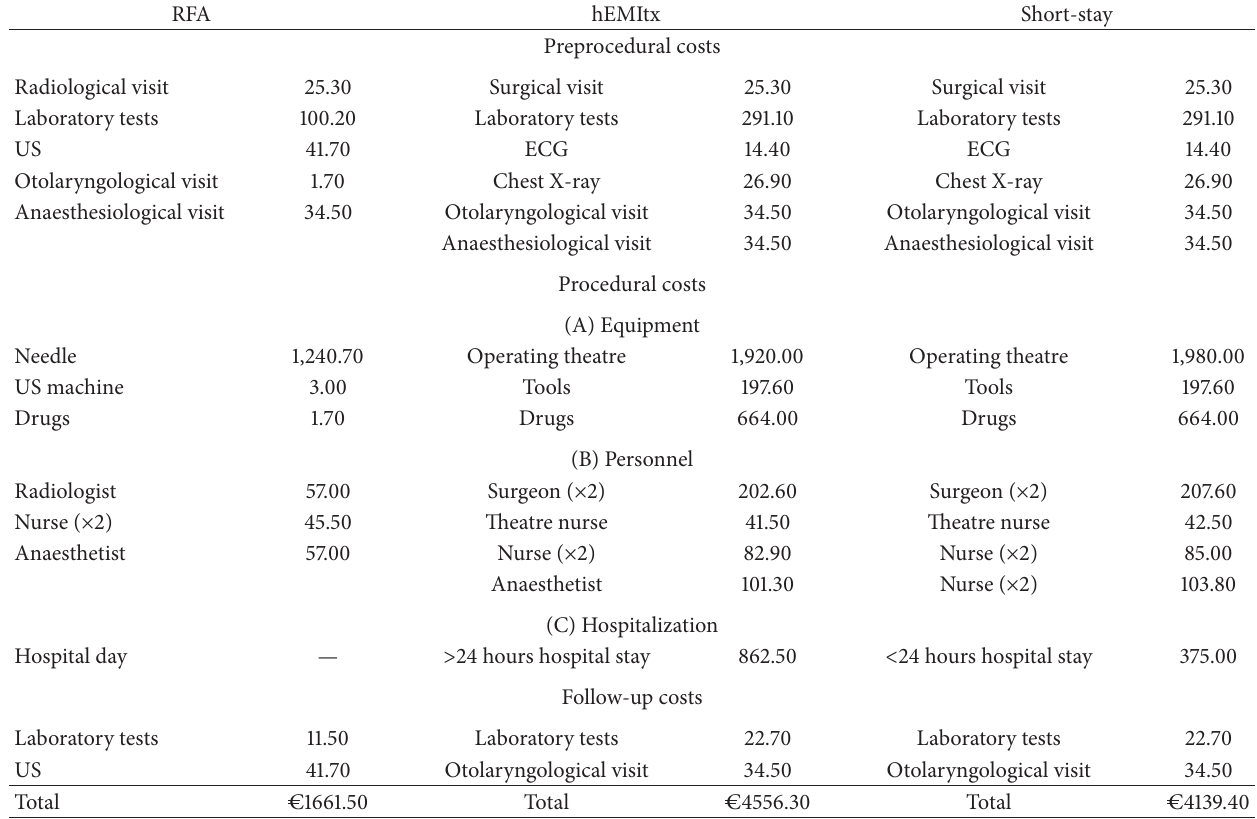
Table 3: Costs of RFA and